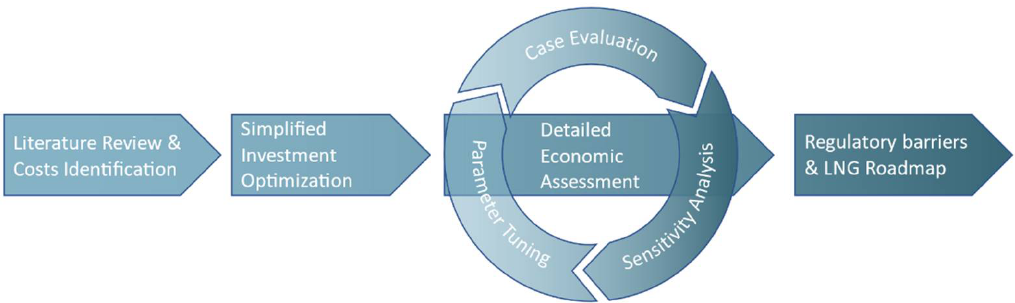
Figure 1. Methodology followed for the techno-economic assessment of the SOFC unit.